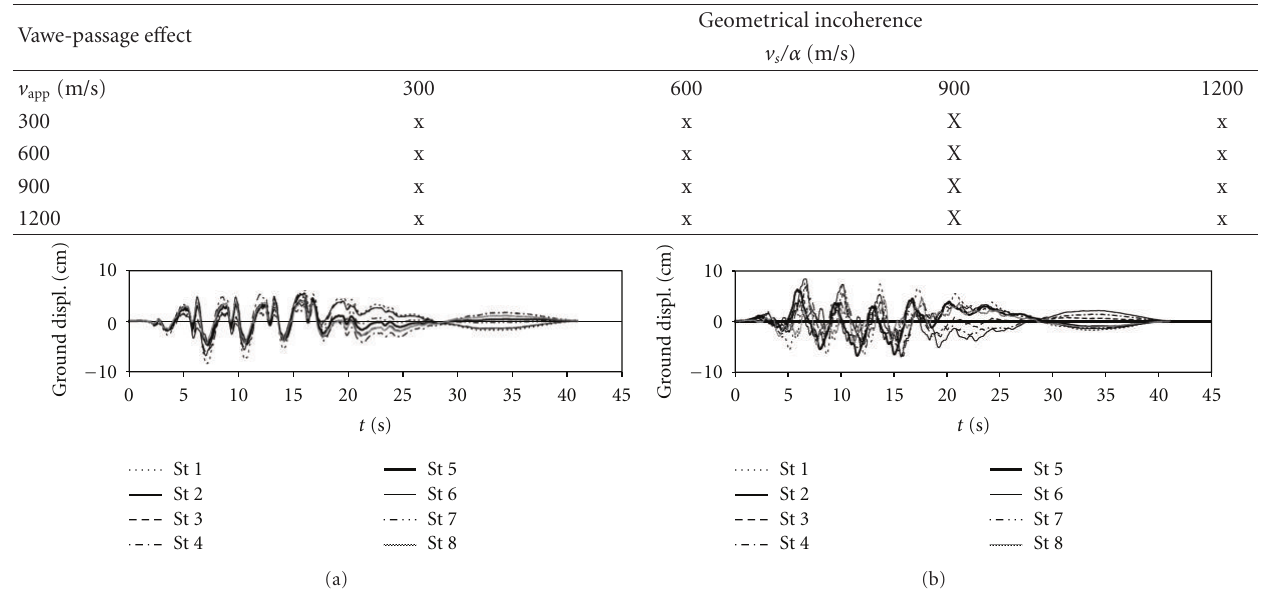
Table 1: Combinations of v s /α and v app values considered in the parametric study.